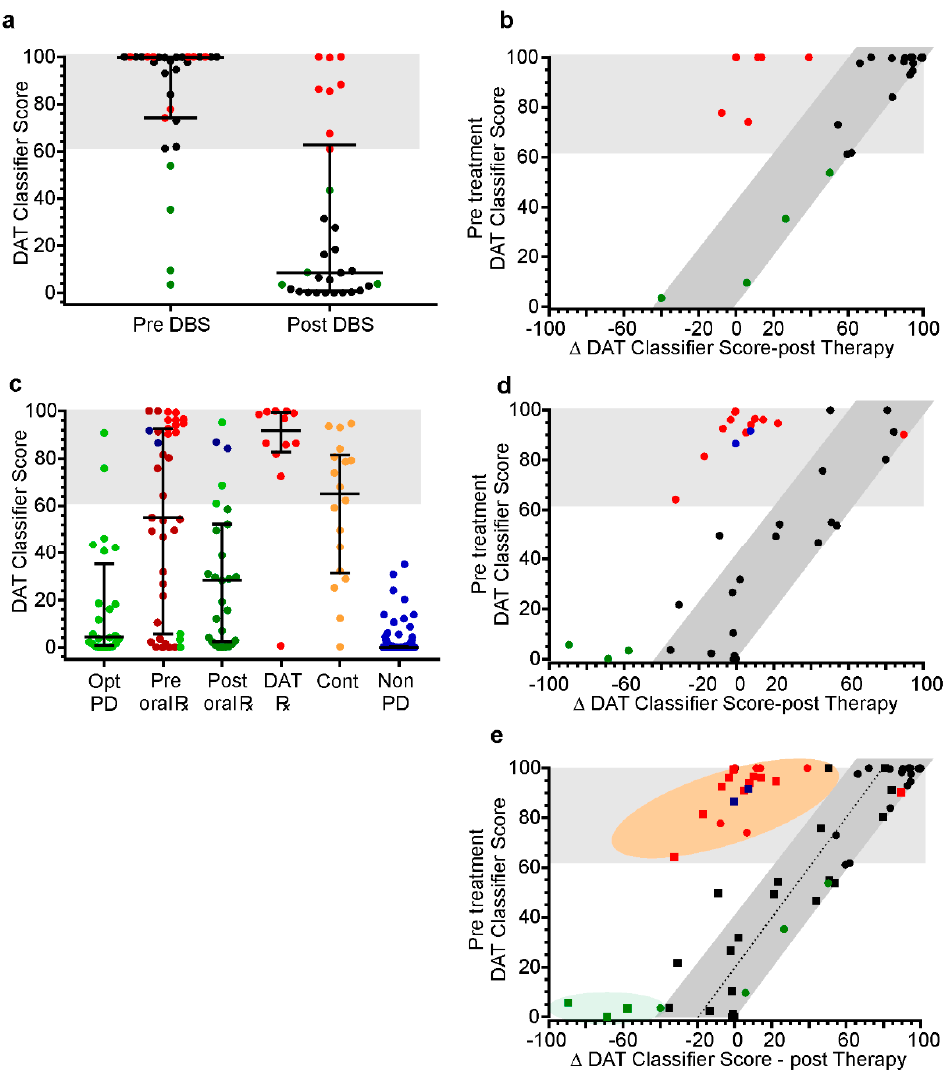
Figure 3. ( a ) Compares DAT classifier scores obtained from PwP prior to receiving DBS and six months after DBS and scores in the shaded area indicate a high risk of DAT being indicated. Green circles indicate four cases (green circles) who were not in this zone. Red circles represent cases whose scores did not fall below the high risk region after DBS. ( b ) Is a plot of each individual PwP’s DAT classifier score prior to DBS (Y axis) plotted against the change in DAT classifier scores after DBS (X axis). The coloring of the circles represents the same cases as in Figure 2a. The grey shading represents the predicted response range. ( c ) Compares DAT classifier scores from the PwP representing all PwP in a single population, (1) Opt PD (light green circles) were optimally controlled cases; (2) Pre Oral R shows the DAT classifier scores of PwP prior to attempting a change in oral therapy. The green circles indicate PwP who were under-treated, but treatment resulted in an increase in DAT classifier scores and their treating clinician now thought DAT was indicated. The blue circles represent two PwP whose DAT classifier scores remained high because of a lack of responsiveness to levodopa and artifactually elevated dyskinesia; (3) Post Oral R are cases whose DAT classifier scores were reduced when measured after the change in therapy (shown as dark red circles in Pre Oral R); (4) DAT R shows cases referred for DAT following attempts to change oral therapy (light red circles Pre Oral R). ( d ) Shows the individual PwP’s (pre Oral R) DAT classifier scores prior to a change in oral therapy (Y axis) plotted against the change in DAT classifier scores following that change (X axis). The coloring of the circles represents the same cases as in Figure 3c. ( e ) Combines Figure 3b,d to propose a response region (grey shading), where an e ff ective optimization of therapy will fall. The region shade orange indicates failed optimization and the region in green indicates where increasing therapy has led an increased DAT classifier score.